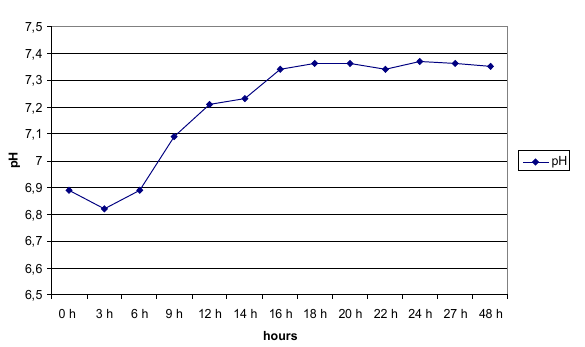
Figure 1. pH values within 48 Figure 1: pH values within 48 hours 6,56,66,76,86,977,17,27,37,47,5